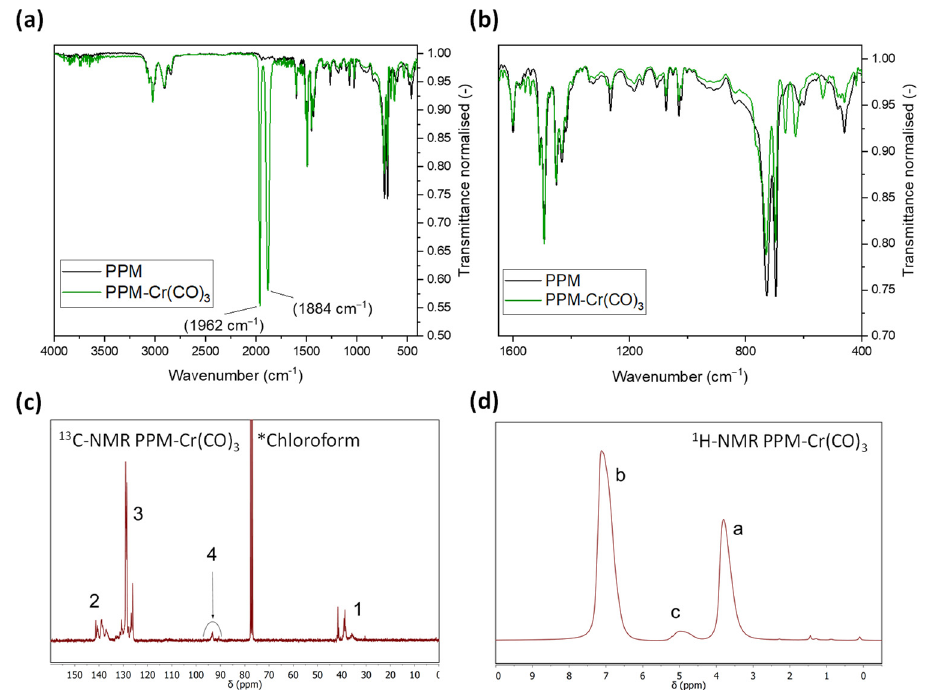
Figure 9. ( a ) and ( b ) IR spectra of PPM (black curve) and PPM-Cr(CO) 3 (green curve, normalized at 1493 cm − 1 ) for two different spectral ranges; ( c ) 13 C NMR spectrum of PPM-Cr(CO) 3 in d 1 -chloroform (200 mg/mL, signal groups 1, 2 and 3 essentially coincident with PPM alone, signal group 4 new); ( d ) 1 H NMR spectrum related to ( c ) (signals a and b essentially coincident with those of PPM alone, signal c new).